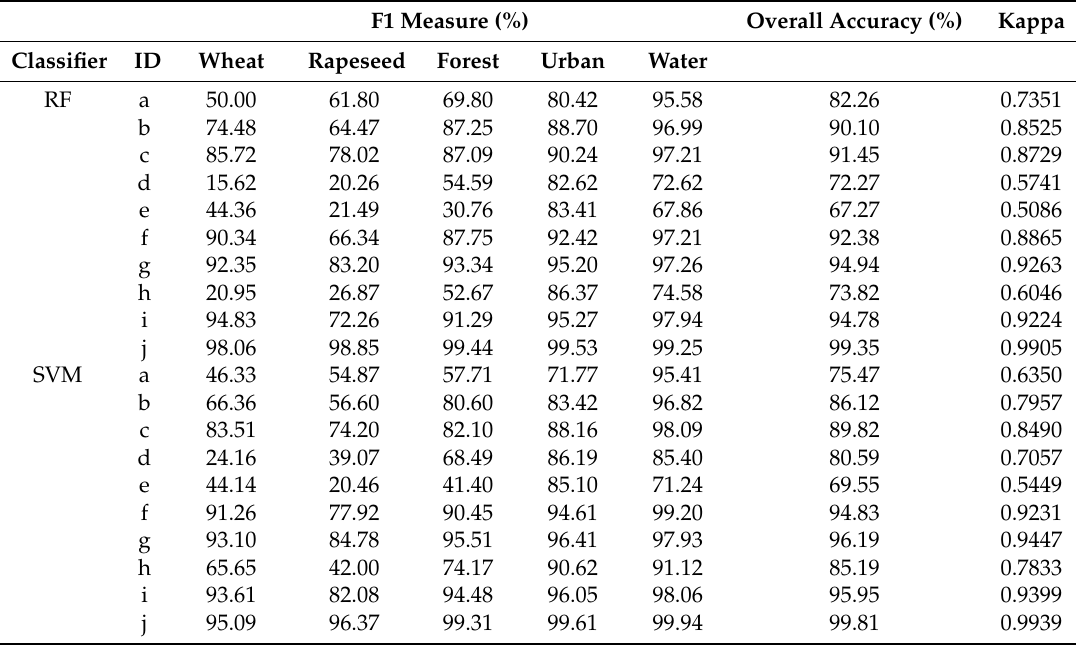
Table 4. Comparison of overall accuracy, kappa coefficient, and F1 measure for each land cover class. F1 Measure (%) Overall Accuracy